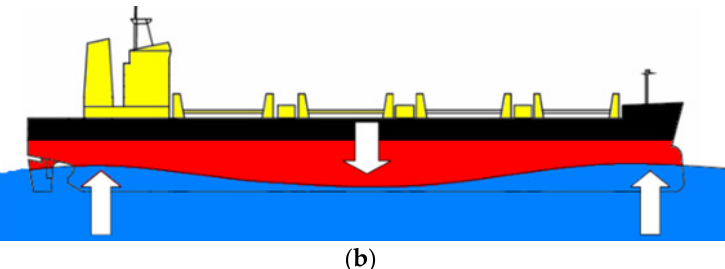
Figure 2. Typical hull girder loads: ( a ) hogging mode; ( b ) sagging mode.